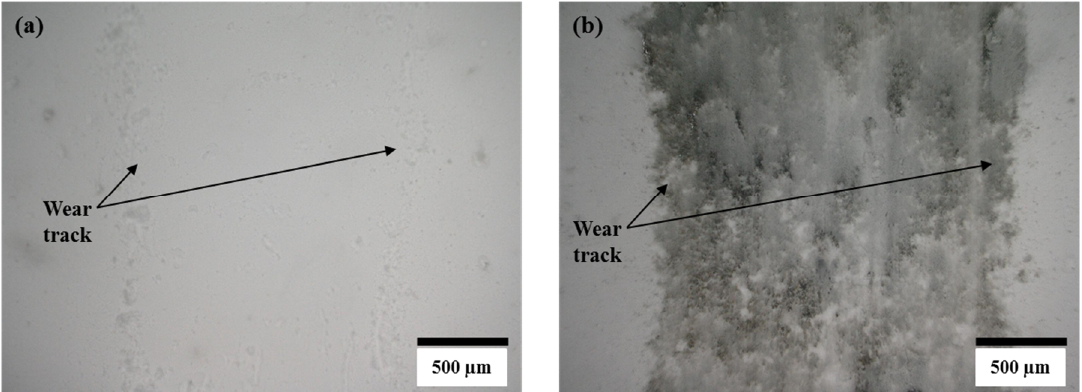
Figure 7. Optical micrographs of wear track on A10 composite after reciprocating sliding test against ( a ) alumina ball and ( b ) steel ball.